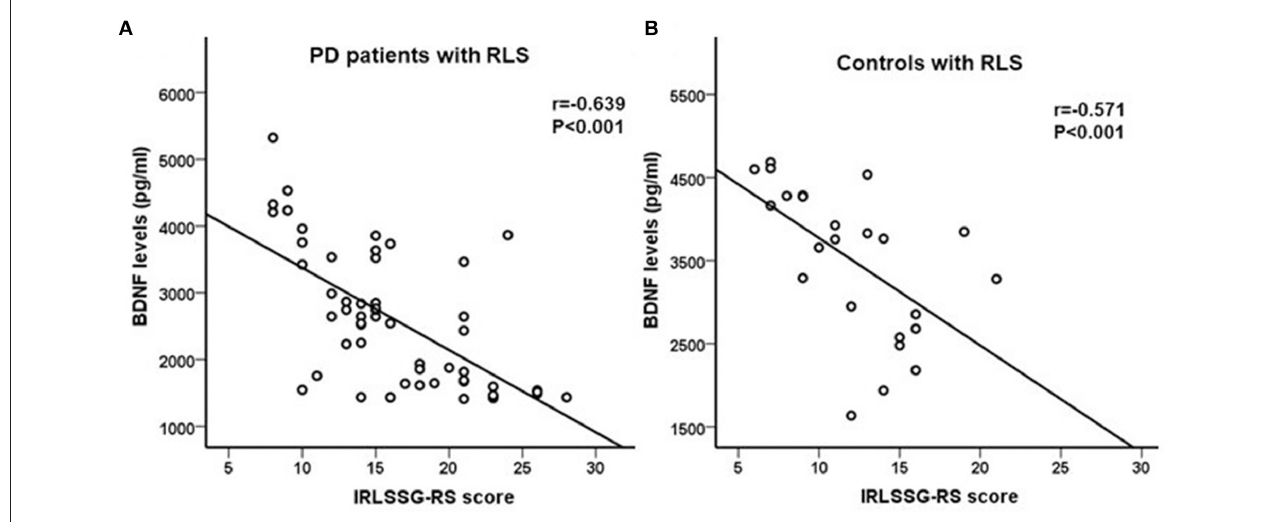
FIGURE 2 | (A,B) Correlation analysis showed a significant negatively association between serum BDNF levels and IRLSSG-RS score in PD patients with RLS and in controls with RLS (both p < 0.001). BDNF, brain-derived neurotrophic factor; IRLSSG-RS, International Restless Legs Syndrome Study Group Rating Scale; PD, Parkinson’s disease; RLS, restless legs